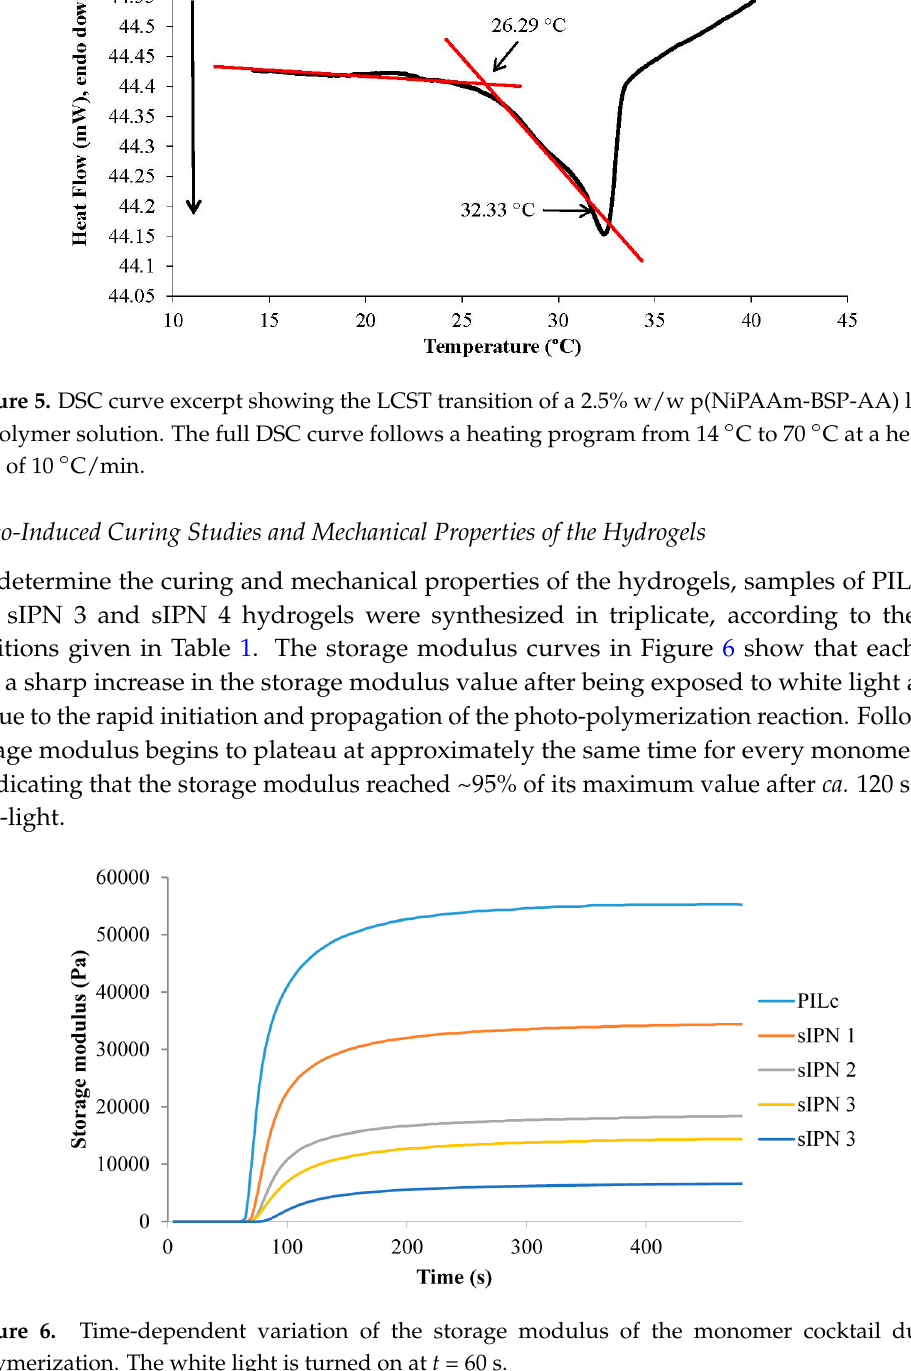
Figure 6. Time-dependent variation of the storage modulus of the monomer cocktail during polymerization. The white light is turned on at t = 60 s.